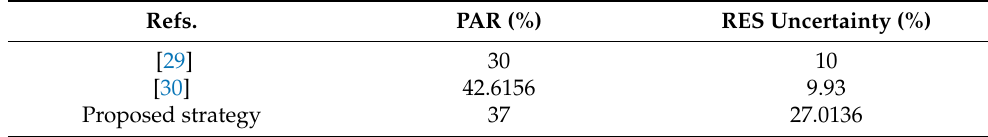
Table 6. Comparison with existing